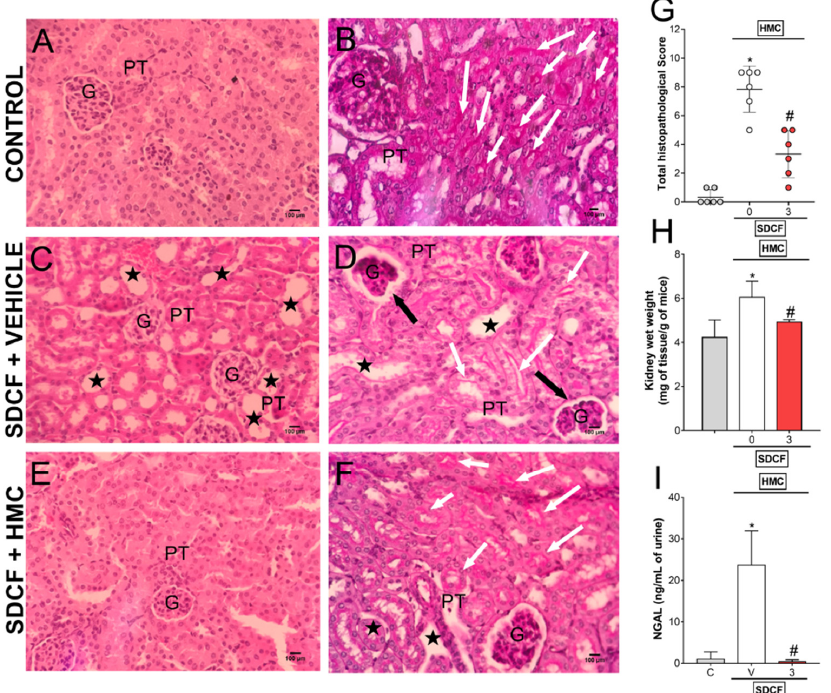
Figure 6. HMC inhibits SDCF-induced renal histopathology, swelling and tubular cells cytotoxicity. Kidney samples were collected 24 h after the administration of SDCF for the evaluation of histopathology with H&E ( A , C , E ), and PAS ( B , D , F ) staining, total histopathological score ( G ), swelling ( H ), and NGAL urinary levels ( I ). Original magnification 40×; 100 μ m scale. Stars show tubular dilatation; black arrows show glomeruli/Bowman’s capsule lesions; and white arrows show brush border differences in varied experimental groups. Data are shown as mean ± SD, n = 12 and n = 6 mice per group per experiment for histopathological analysis and swelling/NGAL, respectively, and are representative of two independent experiments. * p < 0.05 vs. control (C) group; # p < 0.05 vs. SDCF + vehicle (V) treated group; Kruskal-Wallis followed by Dunn’s post hoc test ( G ) and one ANOVA followed by Tukey’s post hoc test ( H , I ). G, glomerulus; PT, proximal